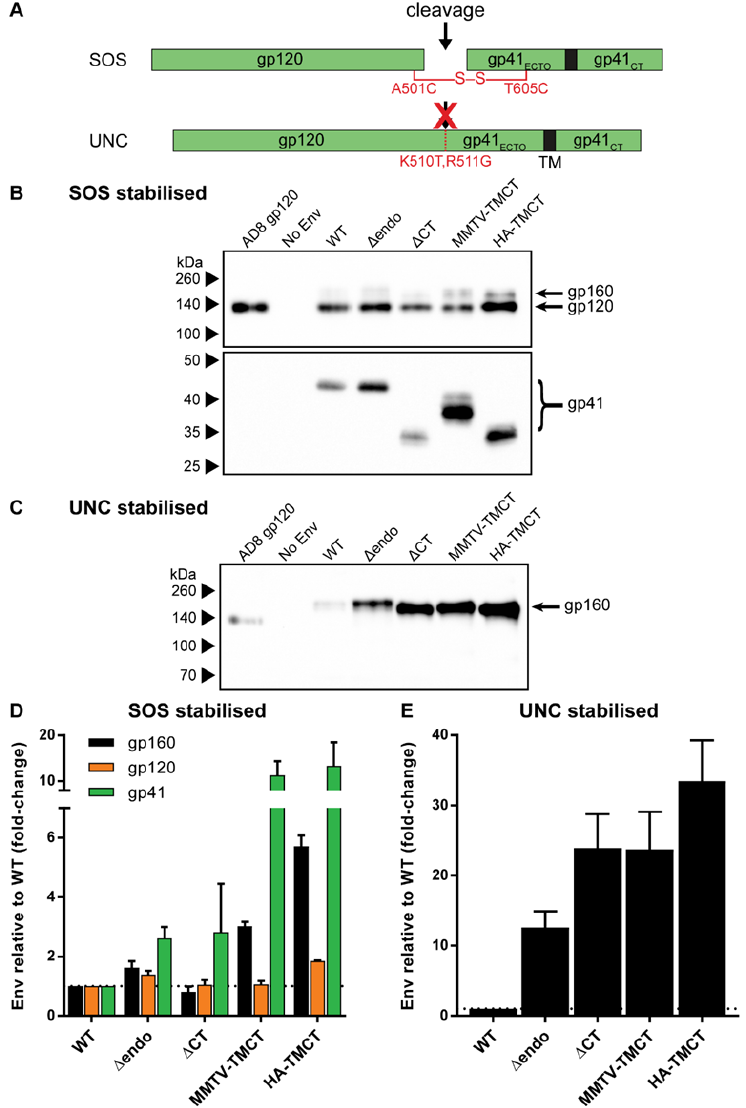
Figure 2. Incorporation of stabilized Env with TM and CT domain modifications into mVLPs. ( A ) Schematic representation